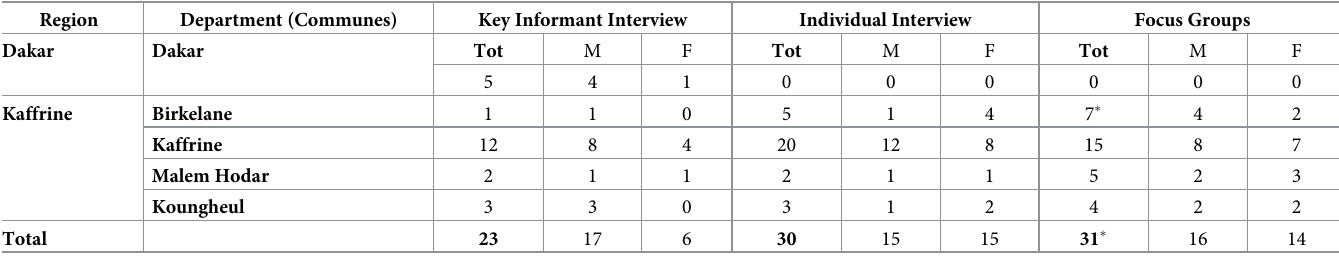
Table 1. Fieldwork data by collection method, location and gender, Kaffrine